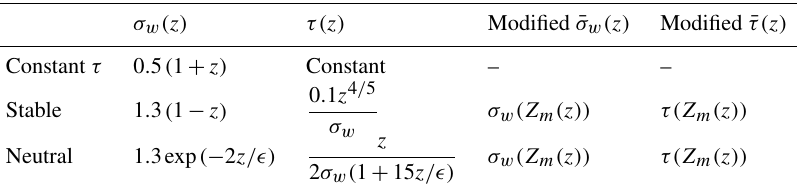
Figure 1. Vertical profiles of vertical velocity fluctuations ¯ σ w (z) (a) and vertical velocity Lagrangian decorrelation time ¯ τ(z) (b) used in the test-case problems (see Table 1). The dimensions for ¯ σ w and ¯ τ are frictional velocity u ∗ and h/u ∗ respectively, where h is the ABL height. Table 1. The non-dimensional profiles of σ w (z) and τ(z) suitable for (i) a constant τ profile, (ii) a stable ABL, and (iii) a neutral ABL (e.g. Hanna, 1982). The non-dimensional parameter (cid:15) = u ∗ /f h is a boundary layer Rossby number (the value (cid:15) = 0 . 8 is taken in the test case). For the purposes of numerical stability (see text), in practice the modified profiles ¯ σ w (z) and ¯ τ(z) are used, where Z m (z) = z b + z( 1 − 2 z b ) is chosen to avoid singular behaviour at the boundaries ( z b = 0 .